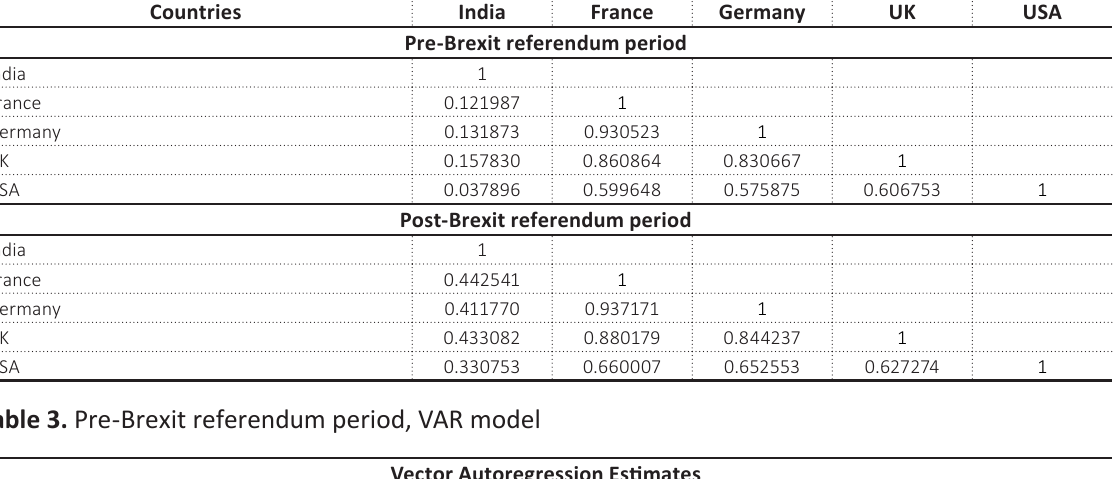
Table 2. Correlation matrix between index returns Countries